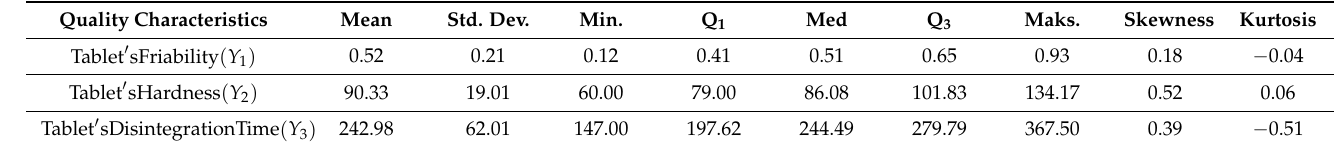
Table 4. Descriptive Statistics of Paracetamol Tablets Quality